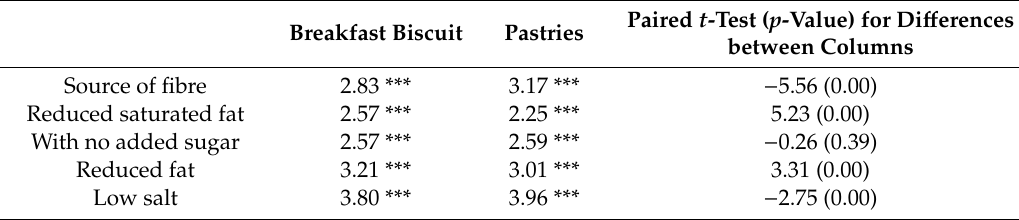
Table 5. Test of di ff erences for the nutritional claims between biscuits and